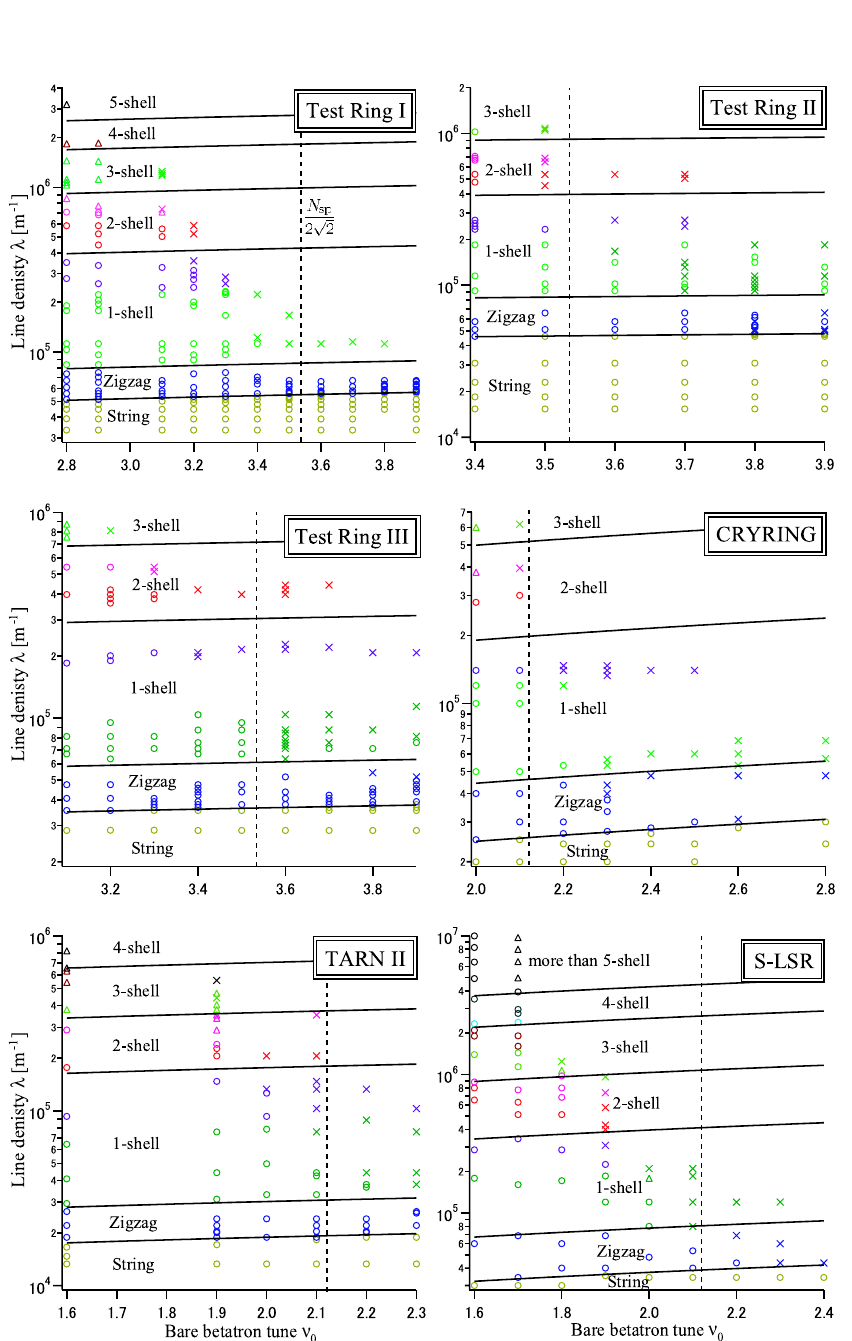
FIG. 8. (Color) Stability diagram of crystalline beams obtained by MD simulations. The ‘‘survival time’’ of a crystalline beam after removing dissipation is represented by either a circle ( (cid:15) ), a triangle ( 4 ), or a cross ( (cid:9) ). (cid:15) stands for stable over 10 4 turns, 4 for melt before 10 4 turns, and (cid:9) for blow-up immediately after removing the cooling force. Different colors correspond to different crystalline structures. The vertical broken line in each panel is (cid:2)